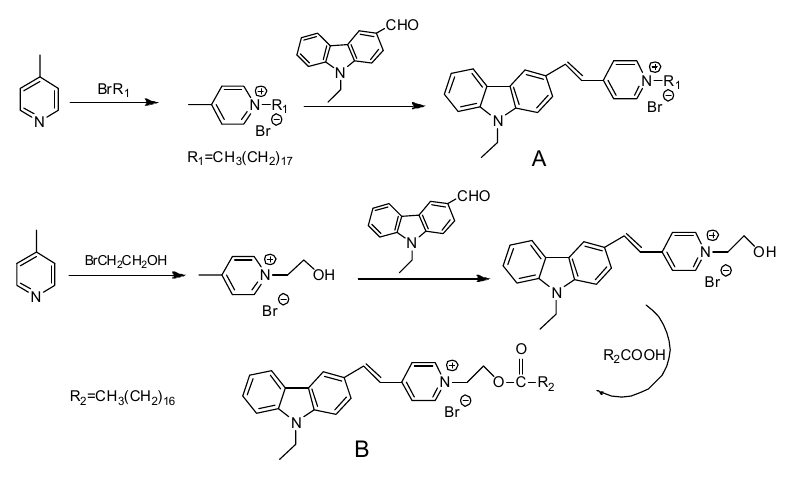
Figure 2. Synthesis of probe A and probe B.